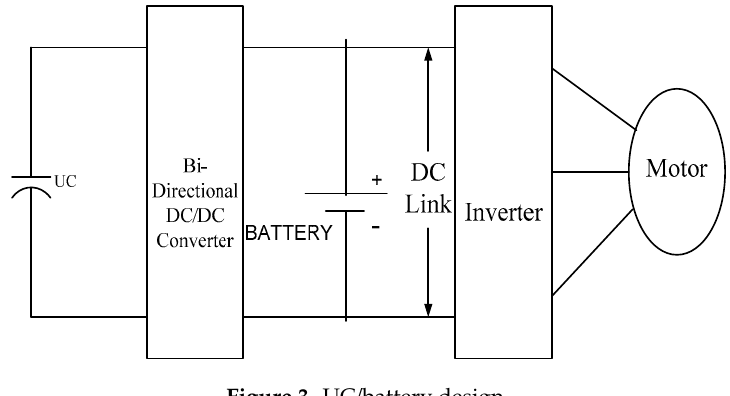
Figure 3. UC/battery design. Figure 3. UC / battery design.